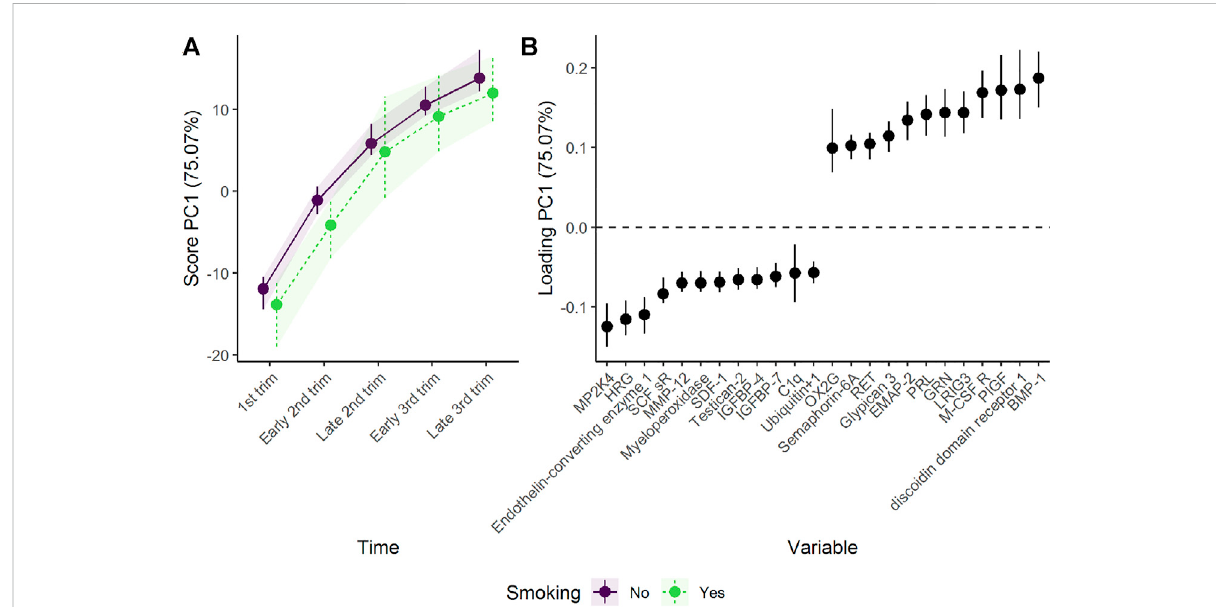
FIGURE 4 Time development of the plasma proteome throughout pregnancy in smoking and non-smoking women as (A) scores and (B) loadings. The plasma level of proteins with high loading is increasing when the scores increase and vice versa . Only the 12 proteins with highest and lowest loadings, separated by the vertical dotted line, are shown due to the large number of assessed proteins.